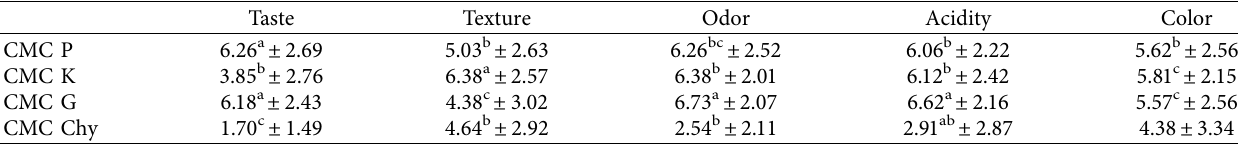
Table 6: Sensory evaluation of camel curd cheese with different